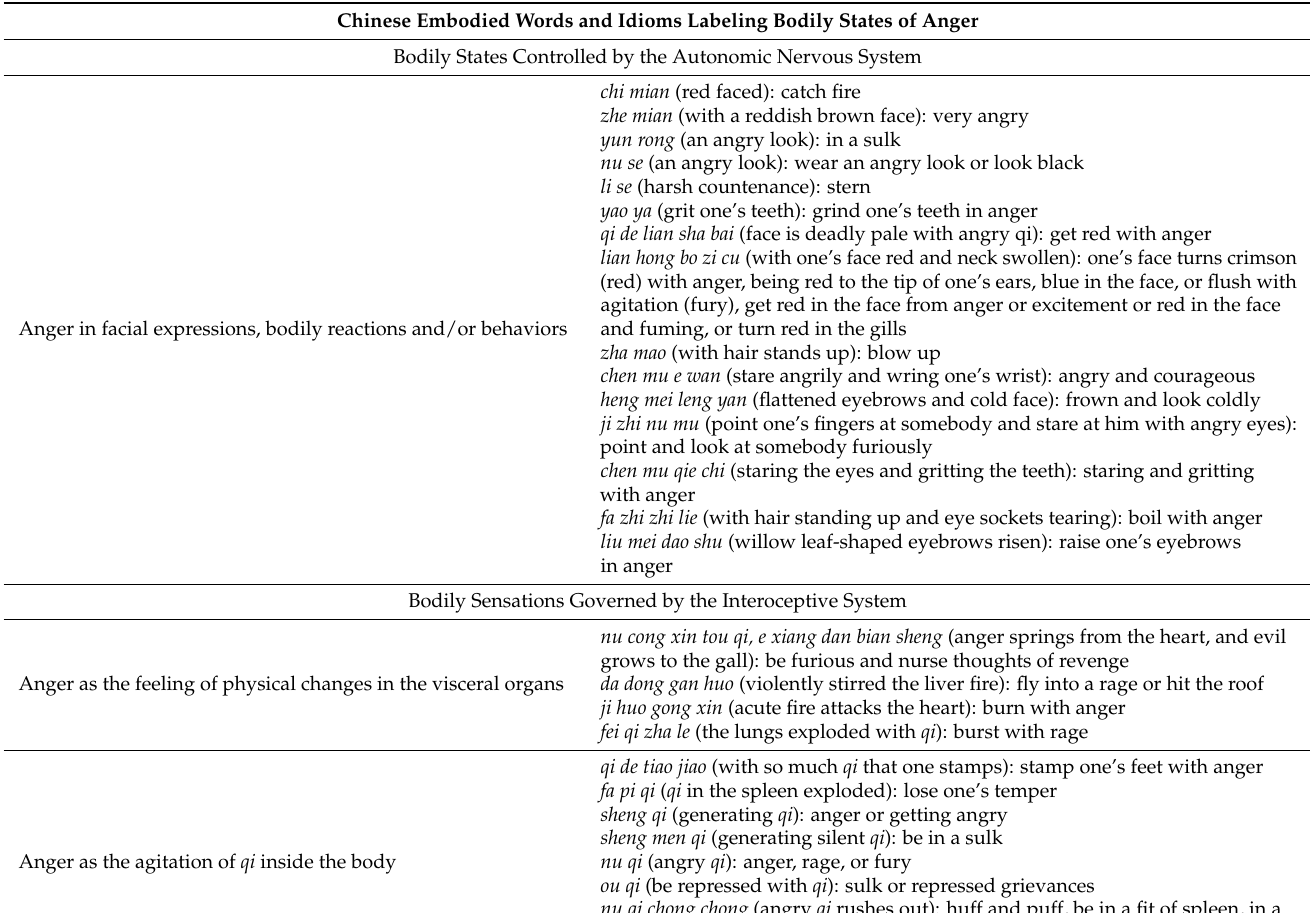
Table 3. Chinese embodied words and idioms labeling bodily states of anger. Chinese Embodied Words and Idioms Labeling Bodily States of